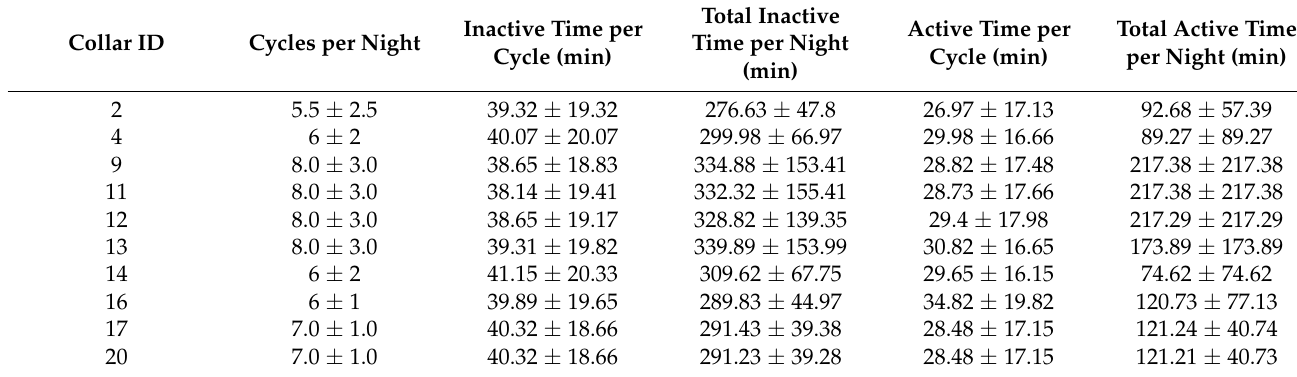
Table 2. Characterization of rest cycles per night (count, rest, and active average times).